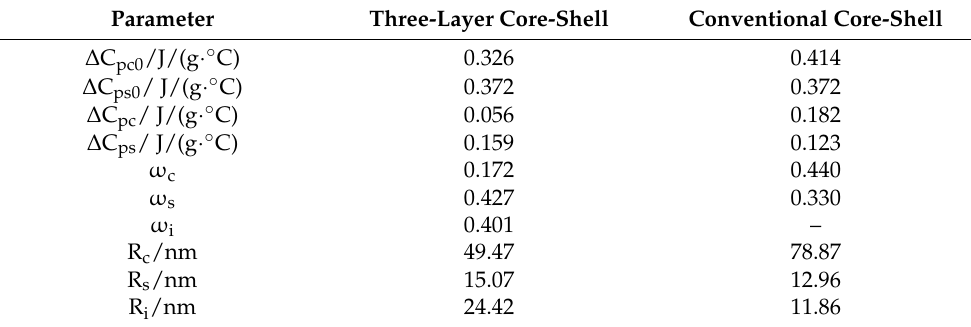
Table 2. Data obtained from TOPEM-DSC curves for the determination of layer thickness. Parameter